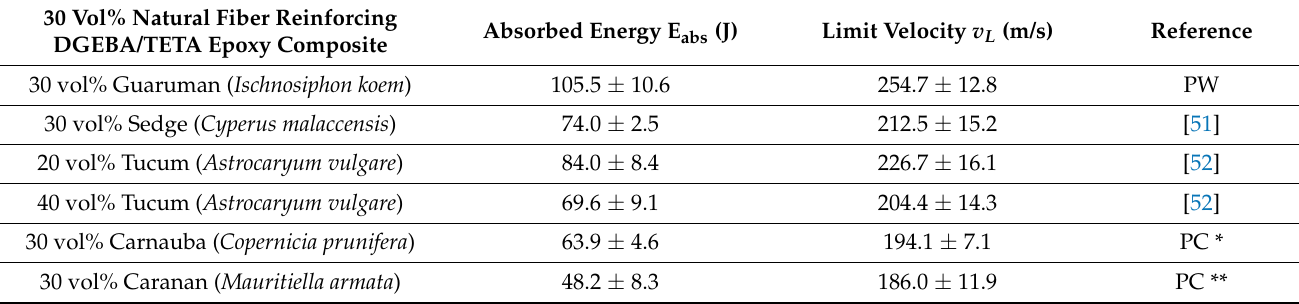
Table 5. Absorbed energy and limit velocity obtained in .22 caliber standalone ballistic tests comparing the present result and those of other DGEBA/TETA epoxy composites reinforced with less known natural fibers. 30 Vol% Natural Fiber Reinforcing DGEBA/TETA Epoxy